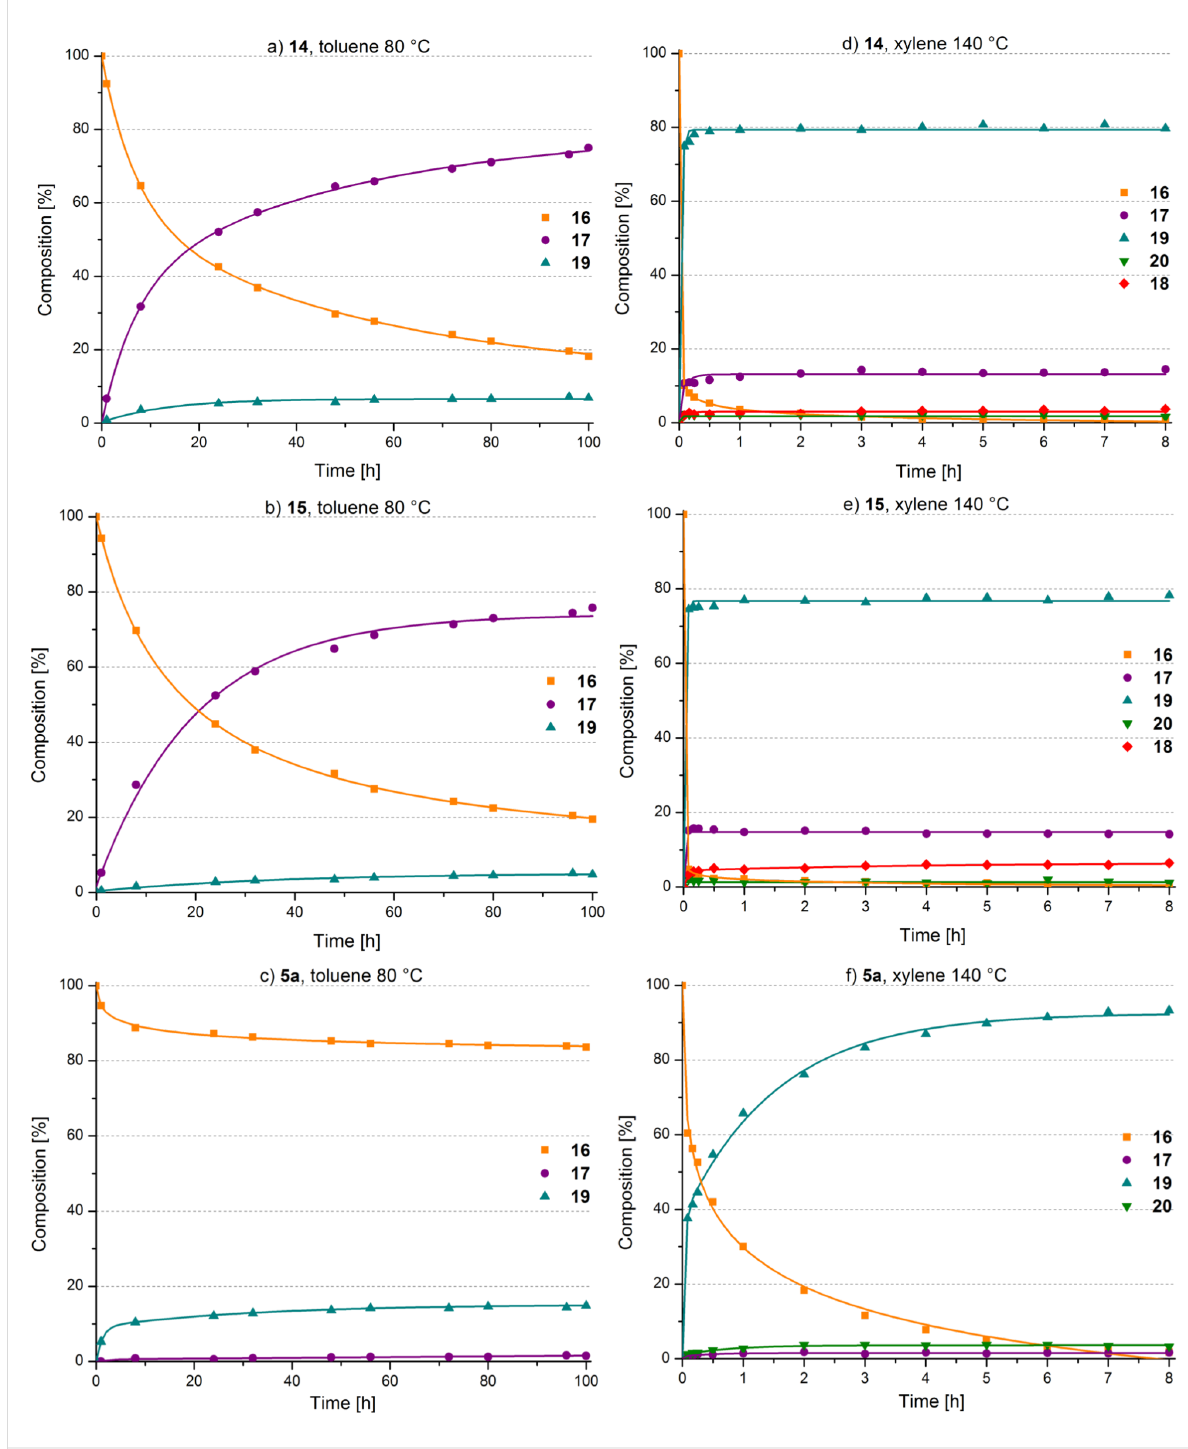
Figure 5: Time/conversion plots for the transformation of 16 catalyzed by 5 mol % of the trans isomers of trans - 5a , 14 and 15 . Lines are intended as visual aids.